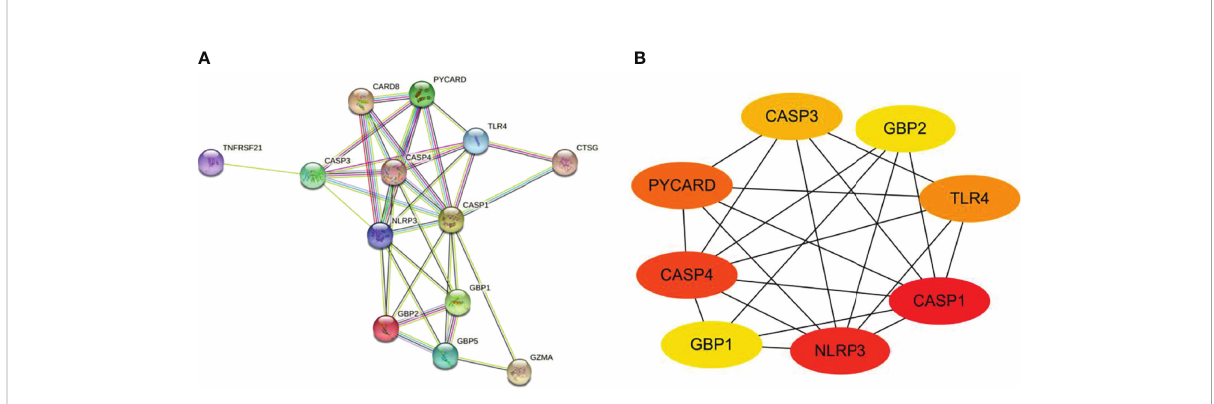
FIGURE 6 Construction of PPI network and identi fi cation of hub genes. (A) The PPI network of 13 differentially expressed PRGs was constructed by using String database. It contains 13 nodes and 35 edges. The average node degree is 5.38, and the PPI enrichment P -value is less than 1.0e-16. (B)